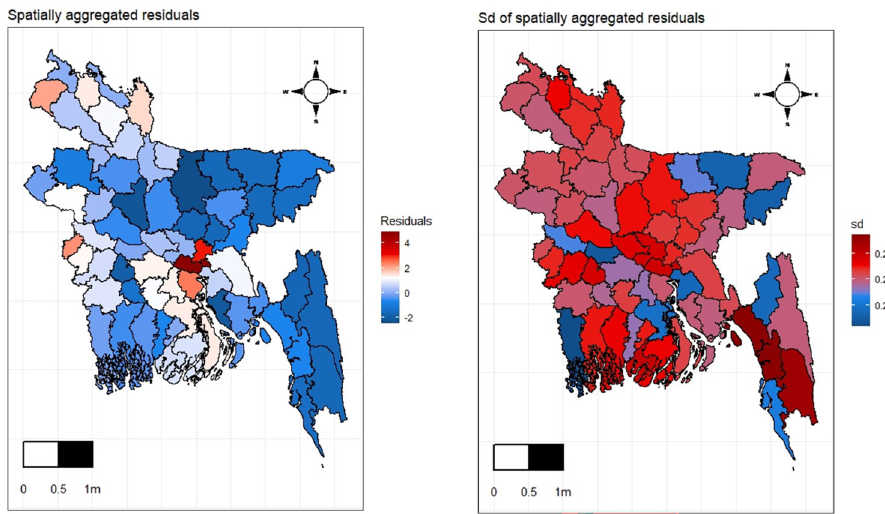
Fig 4. District wise residual plot, (a) spatially aggregated residuals, (b) standard error of the residuals.